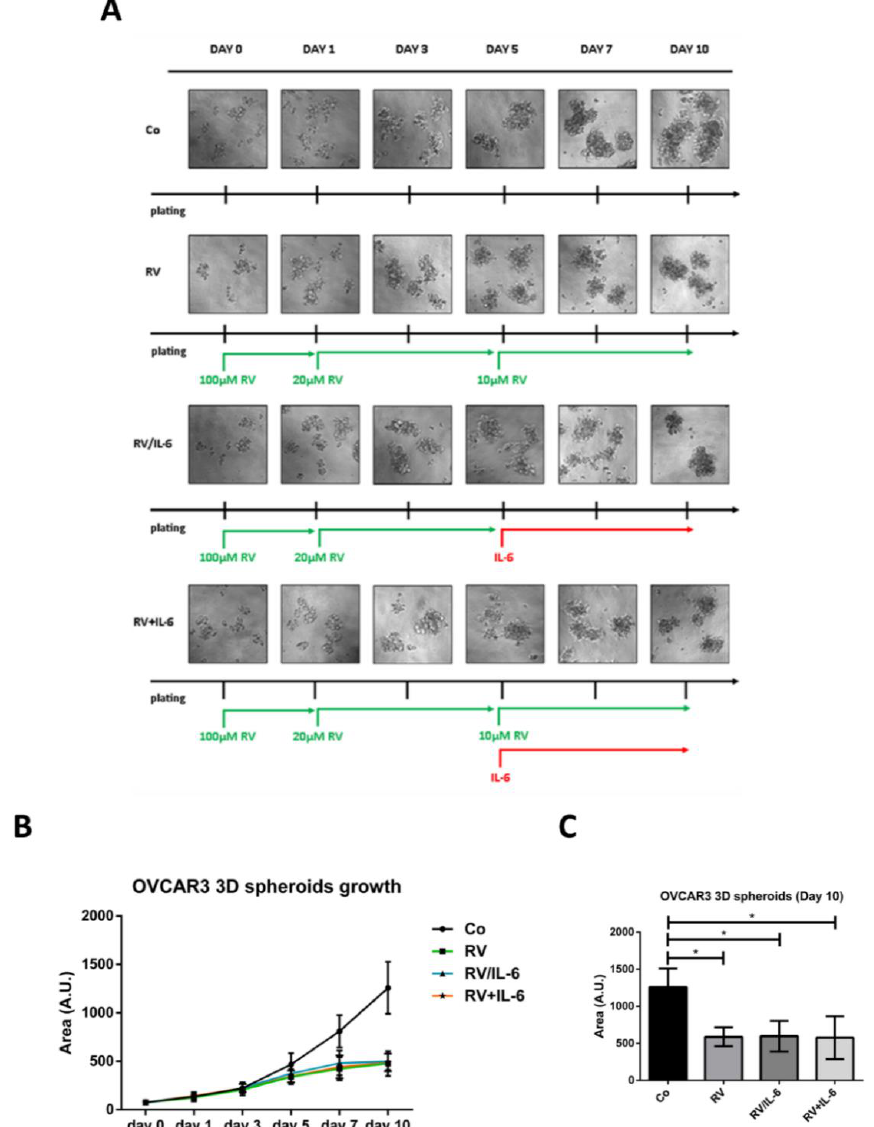
Figure 4. Resveratrol maintains constant the dimensions of 3D ovarian cancer spheroids even in the presence of a pro-inflammatory stimulus. OVCAR3 cells were grown as 3D spheroids. On day 0, cells were exposed to 100 μM RV and re -treated (on days 1 and 3 with 20 μM RV; on days 5 and 7, 10 μM RV was added alone or in combination with 50 ng/ mL IL-6 or replaced by IL-6) up to 10 days. 3D spheroid dimensions were determined with ImageJ software. Data represent the average ± S.D. calculated for three different fields per condition in three separate experiments. ( A ) Time-course phase-contrast photos of OVCAR3 3D spheroids. ( B ) Growth curves represent the dimensions of 3D spheroids during the experimental timeline. ( C ) Graph reporting the quantification of 3D spheroid areas on day 10. Statistical analysis was performed by using GraphPad Prism 5.0 software. Bonfer- roni’s multiple comparison test after one-way ANOVA was employed. Significance was considered as follows: * p < 0.05.